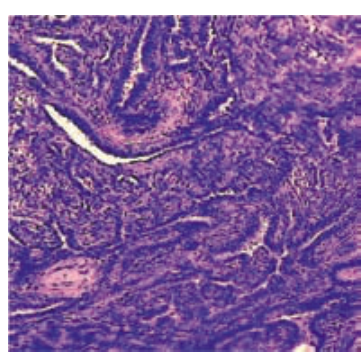
Fig. 4. Sclerotic stroma with mature collagen and less fibroblasts H & E x 100